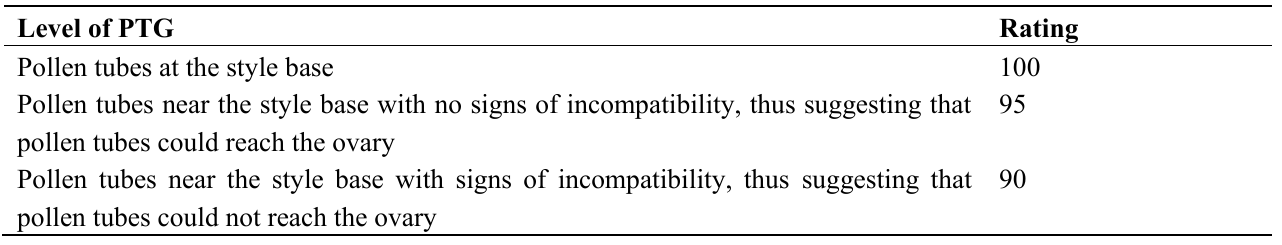
Table 2. Rating of the almond pistils according to the level of pollen tube